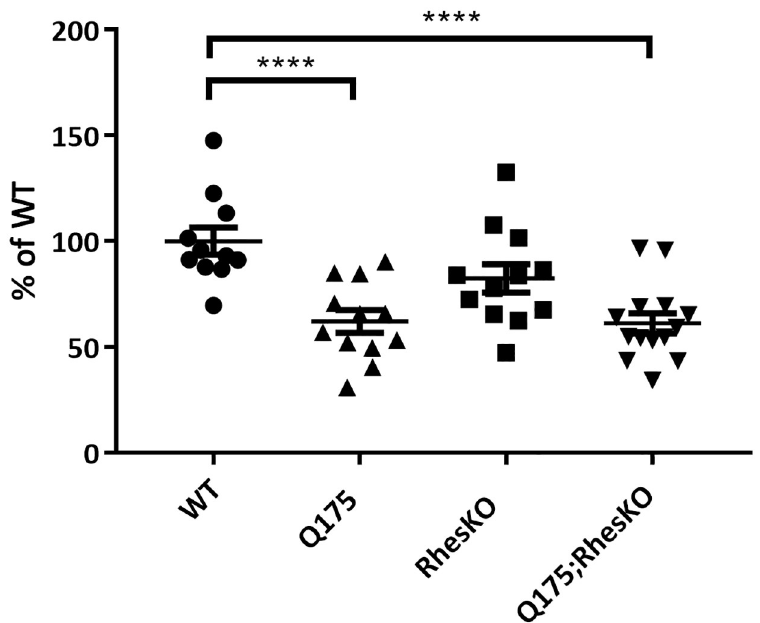
Fig 6. RhesKO did not restore DARPP32 striatal deficit in mixed gender Q175 mice. Quantitation of western blots of 5 month striatal samples from male and female mice probed for DARPP32. For each sample, protein level was normalized to in-lane housekeeping protein (vinculin) and presented as percent of WT. Data presented as mean ± SEM (WT n = 6 females, 5 males; RhesKO n = 5 females, 6 males; Q175 n = 6 females, 6 males; Q175;RhesKO n = 6 females, 8 males); One way ANOVA with Bonferroni multiple comparison test; � p < 0.05, ���� p < 0.0001).